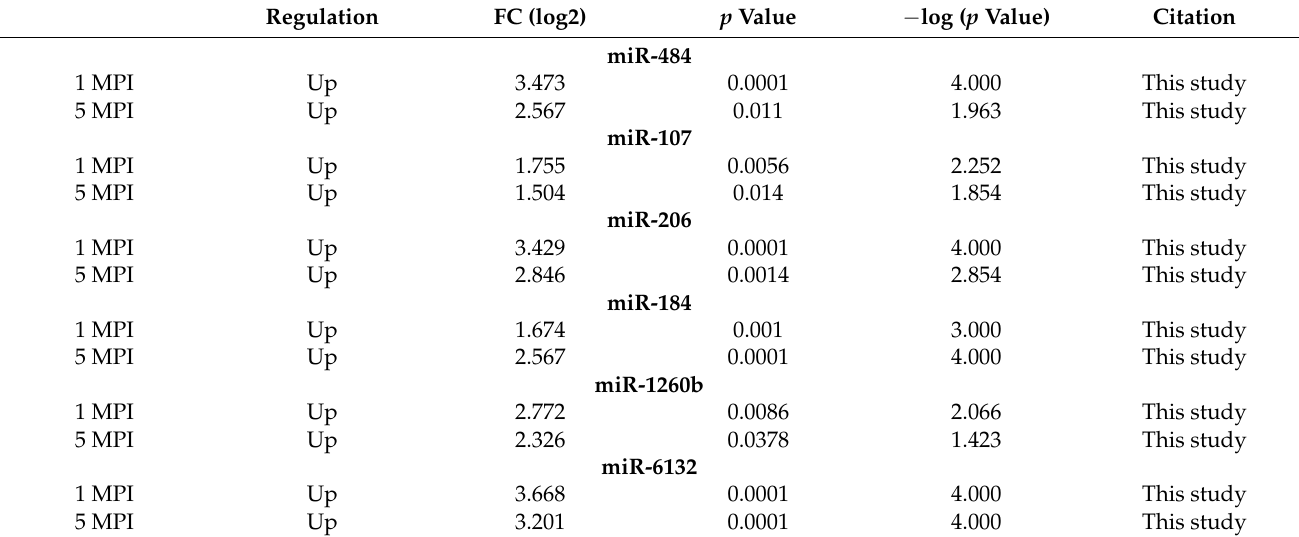
upregulated EV-associated miRNAs in panel A. The blue circles represent the miRNAs, while the target genes are represented by the yellow circles. Pathways are represented by blue lines. ( D ) Dot plot of functional enrichment analysis for the longitudinally upregulated EV-associated miRNAs in panel A. Color of dots represent adjusted p-values (FDR) and size of dots represents gene ratio (number of miRNA targets found enriched in each category/number of total genes associated to that category). ( E ) Volcano plot showing down-(blue) regulated and up-(red) regulated miRNAs in THC/SIV/ART EVs at 1 MPI (left) and at 5 MPI (right). Black arrows indicate longitudinally THC/ART-downregulated miRNAs. ( F ) miRNA-target enrichment analysis showing top target genes by number of interactions for the longitudinally downregulated EV-associated miRNAs in panel E. ( G ) Visualization of miRNA-target interaction network for the longitudinally downregulated EV-associated miRNAs in panel E. The blue circles represent the miRNAs, while the target genes are represented by the yellow circles. Pathways are represented by blue lines. ( H ) Dot plot of functional enrichment analysis for the longitudinally downregulated EV-associated miRNAs in panel E. Color of dots represent adjusted p-values (FDR) and size of dots represents gene ratio (number of miRNA targets found enriched in each category/number of total genes associated to that category. ( I ) Volcano plot showing down-(blue) regulated and up-(red) regulated miRNAs in THC/SIV/ART ECs at 1 MPI (left) and at 5 MPI (right). Black arrows indicate longitudinally THC/ART-downregulated miRNAs. ( J ) miRNA-target enrichment analysis showing top target genes by number of interactions for the longitudinally downregulated EC-associated miRNAs in panel I. ( K ) Visualization of miRNA-target interaction network for the longitudinally downregulated EC-associated miRNAs in panel I. The blue circles represent the miRNAs, while the target genes are represented by the yellow circles. Pathways are represented by blue lines. ( L ) Dot plot of functional enrichment analysis for the longitudinally downregulated EC-associated miRNAs in panel I. Color of dots represent adjusted p-values (FDR) and size of dots represents gene ratio (number of miRNA targets found enriched in each category/number of total genes associated to that category. Table 4. Longitudinal regulation of EV-associated miRNAs by ART in SIV-infected